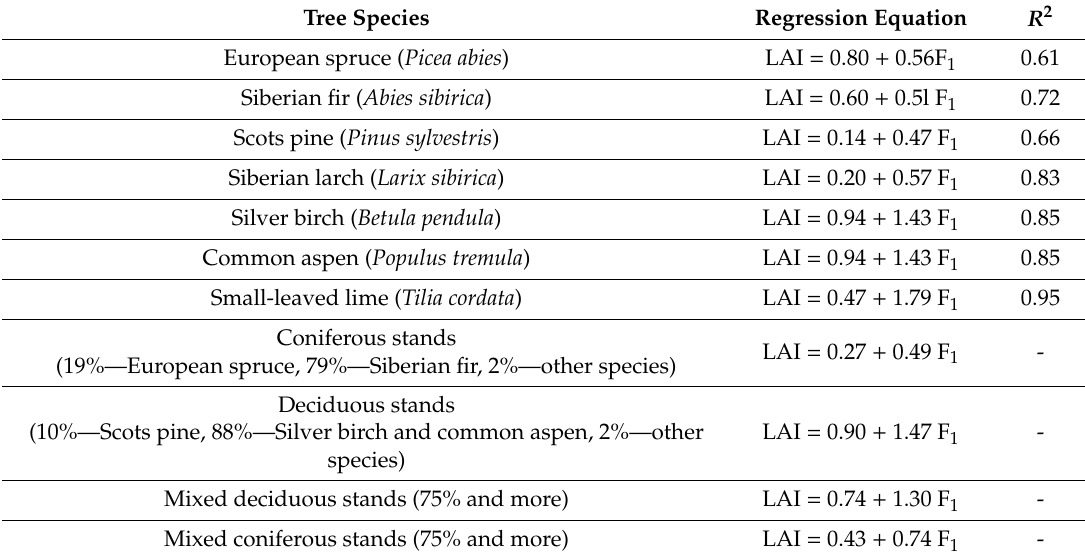
Table 4. LAI values (ha / ha) and its correlation with leaf mass F 1 , (t / ha) [9]. Tree